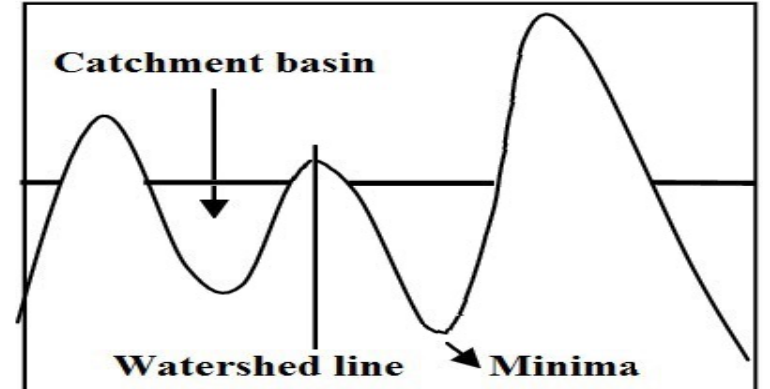
Figure 3. Sight of watershed transformation [32].